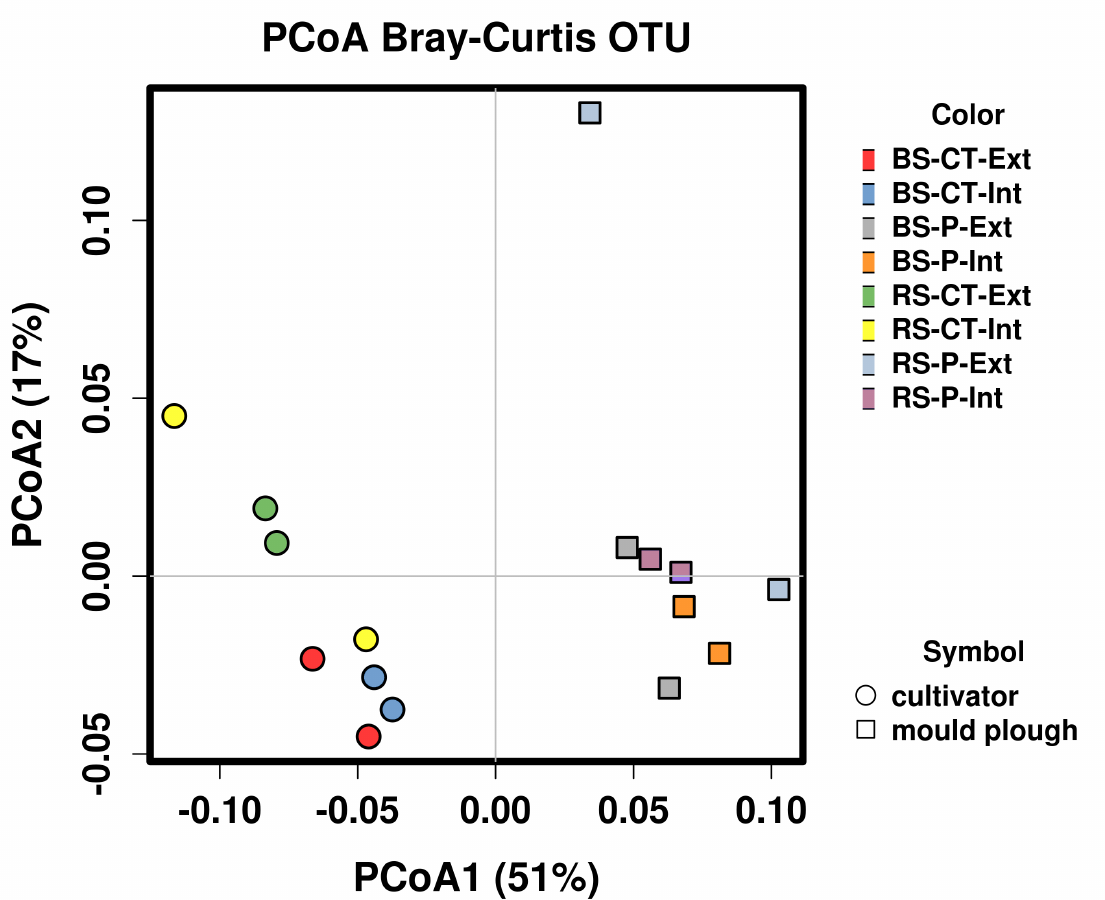
Figure 6. Principal coordinate analysis of abundance data obtained for 162 metagenomically assembled genomes (MAGs) of the soil microbial communities analyzed. The scatter plot shows principal coordinate axis 1 (PCoA1) versus principal coordinate axis 2 (PCoA2) that explain 51% and 17% of the total variance, respectively. In addition, 162 MAGs ( > 20% completeness and ≤ 15% contamination by means of checkM) were used for this analysis. Cultivator-treated samples are represented by circles, mould-plough treated samples by rectangles. Abbreviations stand for bulk soil (BS) or root-affected soil (RS), tillage by mould-board plough (P) or cultivator (CT), and nitrogen fertilization intensive (Int) or extensive